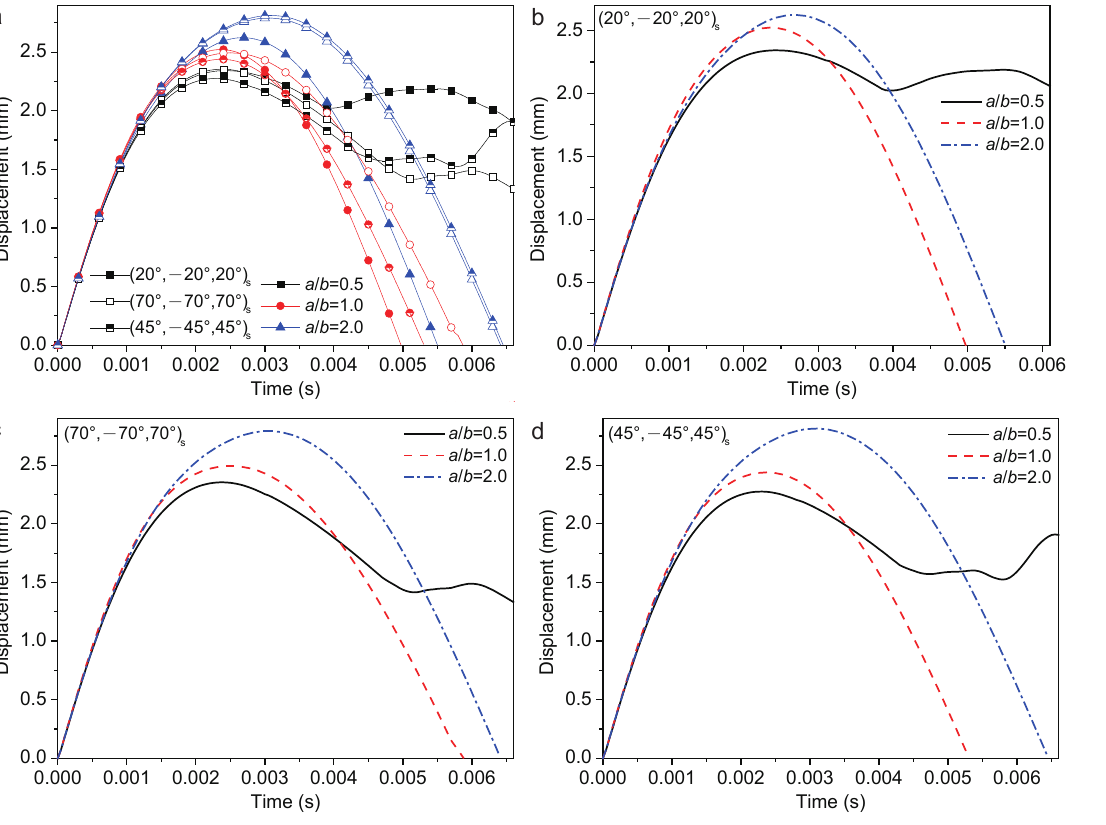
Figure 12. Plate center displacement response of the sandwich structure with various a / b : ( a ) FG-O, UD, and FG-V face sheets plate; ( b ) (20/ − 20/20)s plate; ( c ) (70/ − 70/70)s plate; and ( d ) (45/ − 45/45)s